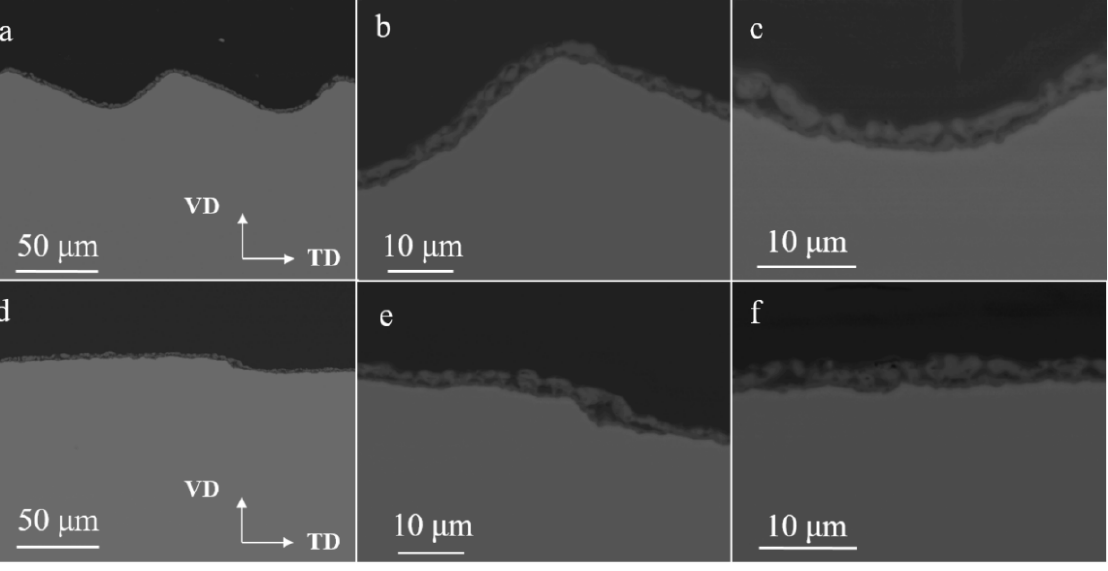
Figure 10. Cross-section SEM of G1-PEO ( a – c ) and G2-PEO ( d – f ) coatings. Notice that cross-sections corresponded to the VD-TD plane across the micro-grooves.